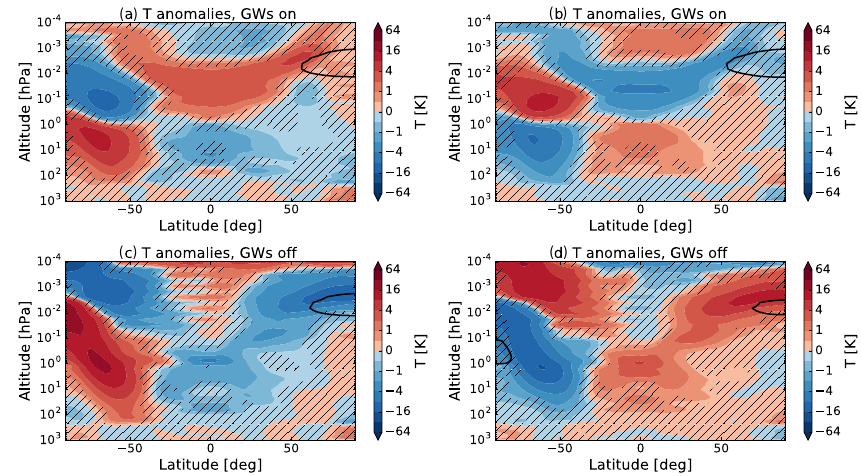
Figure 3. The temperature anomalies for high (a, c) and low (b, d) planetary wave (PW) activity, as measured by the temperature in the winter stratosphere (1–10hPa, 60–40 ◦ S) in July for the control run (a, b) and run without GWs in the winter hemisphere (c, d) . There are 10 years of data with high temperature anomalies and 9 years with low temperature anomalies in the winter stratosphere, this is the case for both the runs with and without the GWs in the winter hemisphere. The hatched areas are regions where the data does not reach a confidence level of 95%. The black 150K contour indicates the polar mesopause